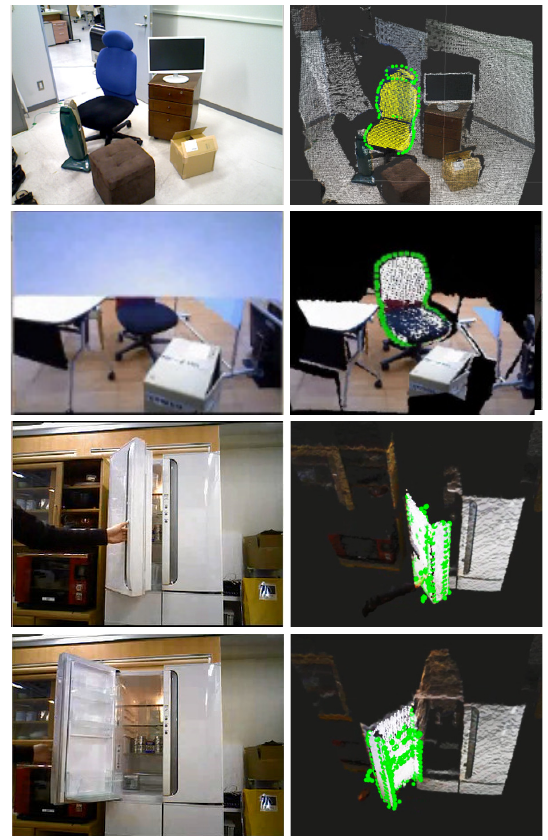
Figure 16: Three detection results. Top row: oflce chair detection in a cluttered environment having several surfaces. Second row: The back of a chair was artificially occluded, but the pose of the chair could be detected. Third and fourth rows: refrigerator door detection using a unified model of two sides of the door.